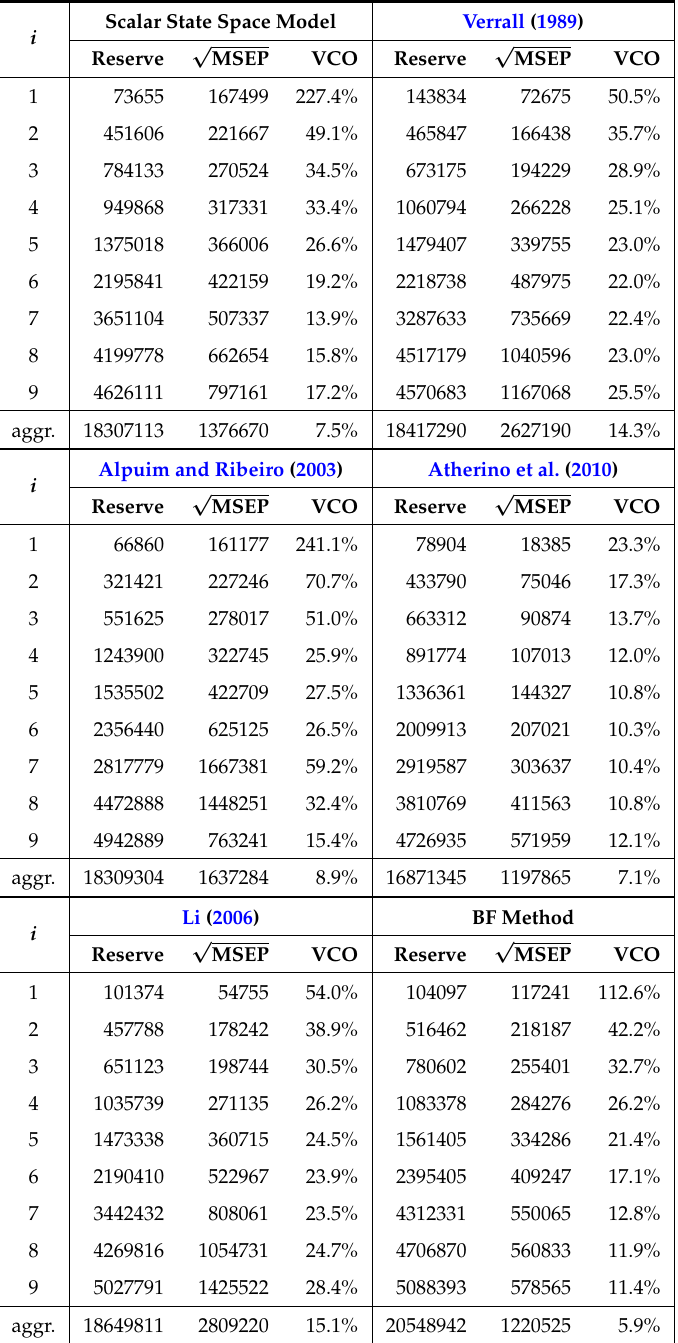
Table 5. Reserves, standard errors and VCOs for selected